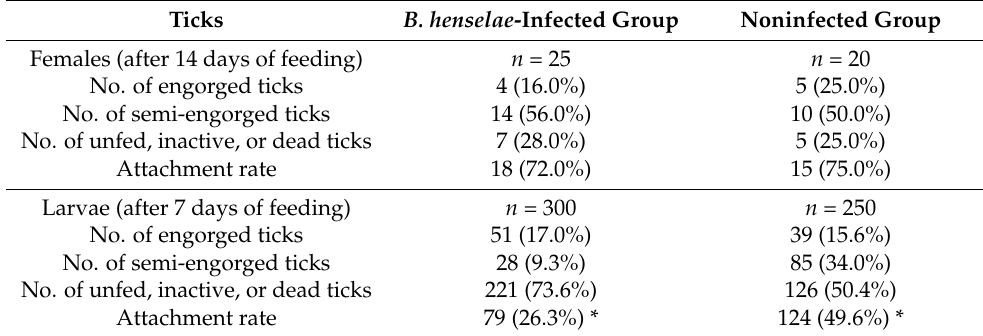
Figure 2. Rhipicephalus sanguineus s.l. adults engorged by artificial membrane feeding system and tick samples collected/dissected during and after feeding. ( a ) Ticks attached to the mouse skin; ( b ) engorged R. sanguineus s.l. female (left) and semi-engorged female (middle) and male (right); ( c ) pools of fecal samples collected from tick containers at 12 h (left) and 24 h (right) after the beginning of the experiment; ( d ) dissected salivary glands from semi-engorged ticks; ( e ) dissected midgut from semi-engorged ticks; ( f ) dissected ovaries from adult ticks. Table 1. Number of R. sanguineus s.l. females and larvae engorged on B. henselae -infected (experimen- tal group) or noninfected (control group) goat blood though artificial membrane feeding system. Ticks B. henselae -Infected Group Noninfected